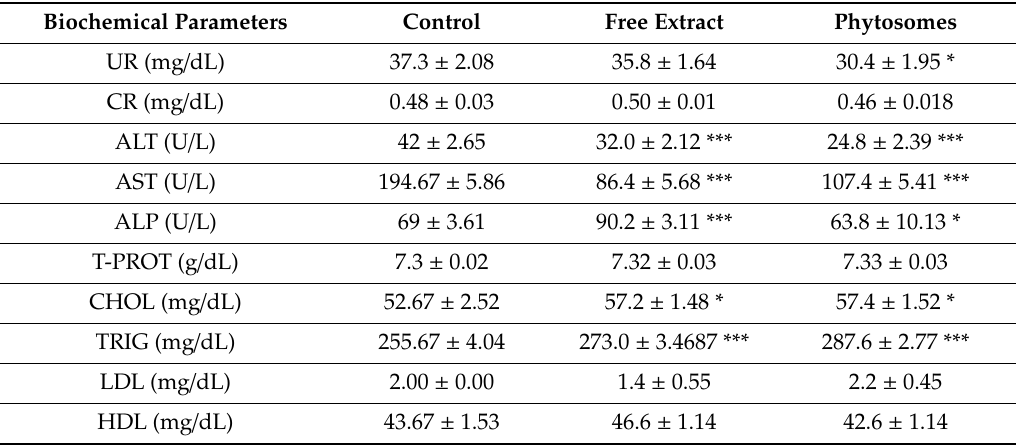
Table 7. The biochemical parameters after 15 days of oral administration. The data has been expressed as the means ±